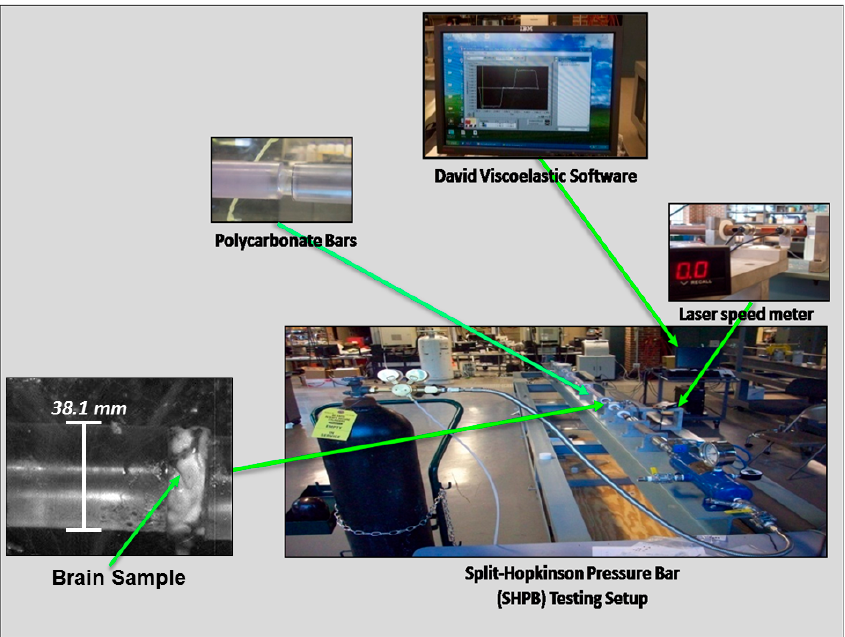
Figure 2. Overview of the Split-Hopkinson pressure bar (SHPB) used to conduct high-strain-rate tests on porcine brain specimens. Strain rates ranged from 50 to 750 s − 1 .